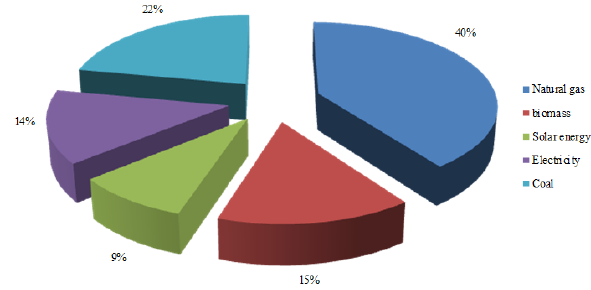
Figure 3: Percentage share of individual energy carriers used in single-family housing in DHW systems. Source: Own